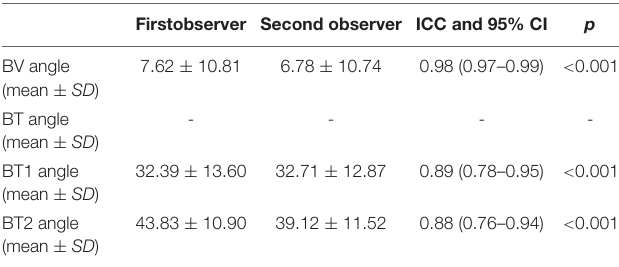
Means of BV and BT angles measurements performed by YR and LJ, with the interobserver correlation index and its significance with 95% confidence interval. ICC, Intraclass correlation coefficient; CI, confidence